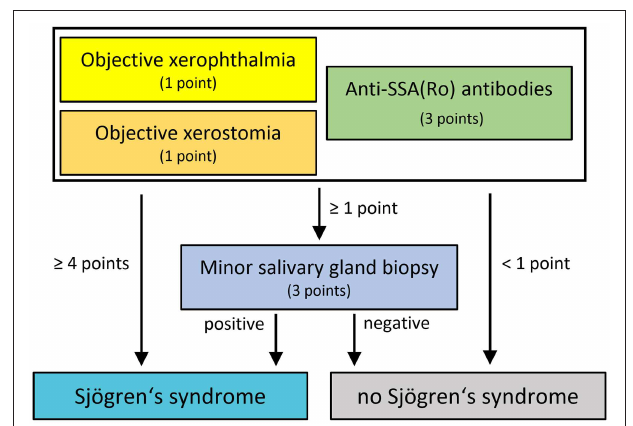
FIGURE 1 | Diagnostic approach for evaluation of Sjögren’s syndrome in patients with